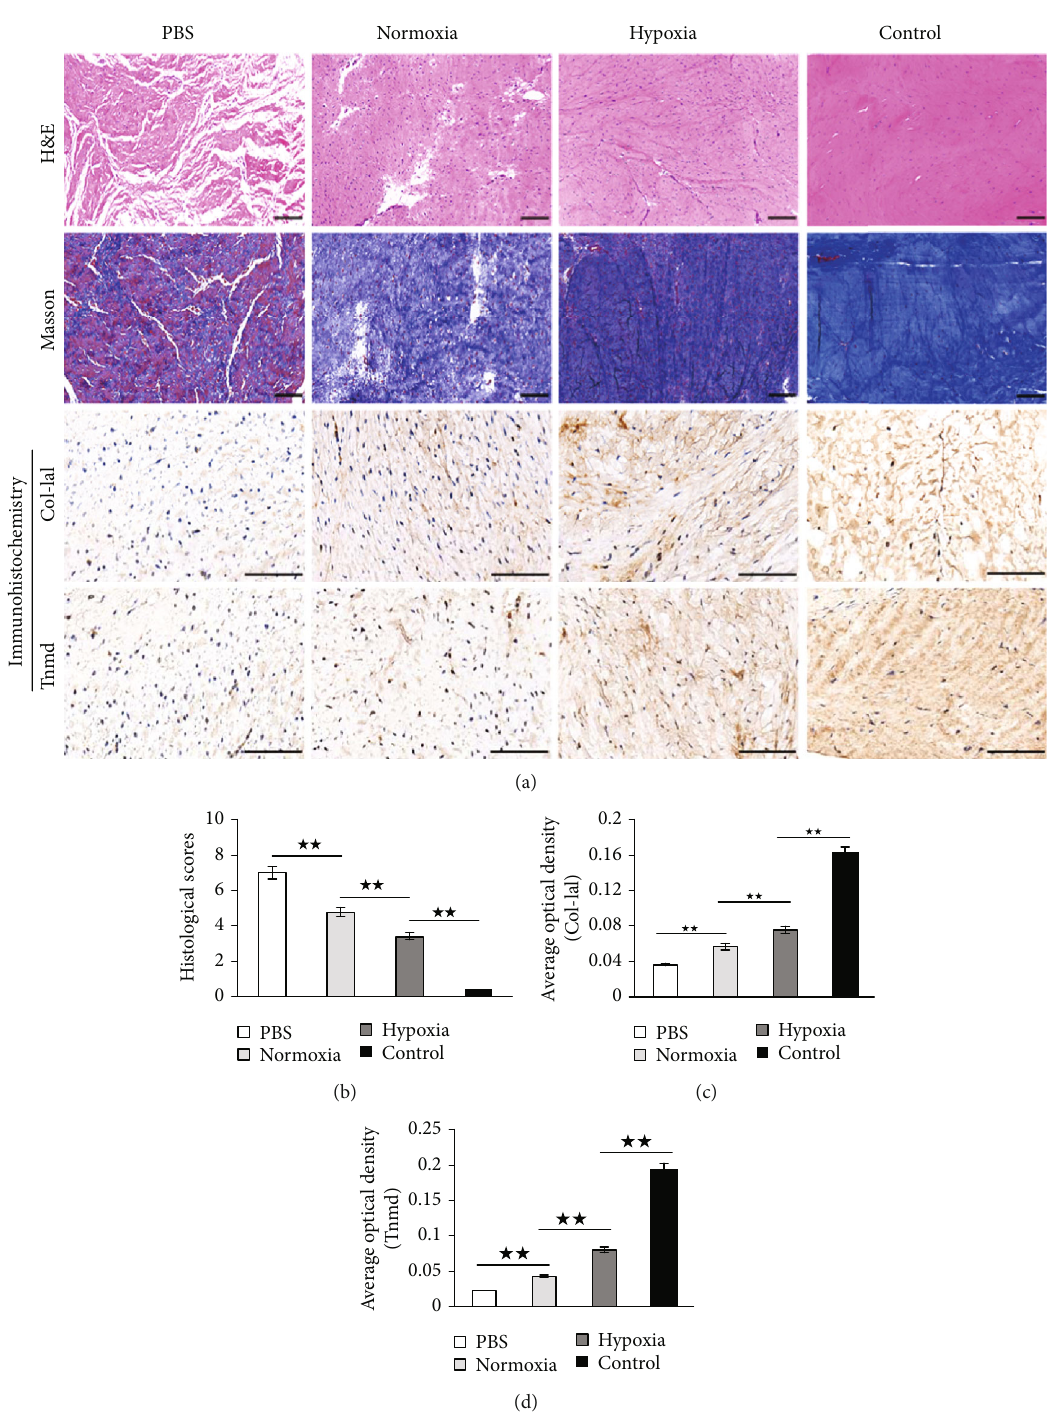
Figure 6: Histological analysis of specimen at 4 weeks after surgery. (a) Hematoxylin and eosin (H&E) staining, Masson ’ s trichrome staining, and immunohistochemical staining for Col-1a1 and Tnmd in the PBS group, the normoxia group, the hypoxia group, and the control (normal) group. (b) Quanti fi cation of histological properties after H&E staining in the PBS group, the normoxia group, the hypoxia group, and the control (normal) group. (c, d) Quanti fi cation of Col-1a1 (c) and Tnmd (d) after immunohistochemical staining in the PBS group, the normoxia group, the hypoxia group, and the control (normal) group. H&E and Masson ’ s trichrome staining: scalebar = 200 μ m; magni fi cation: × 200. Immunohistochemical staining: scale bar = 200 μ m; magni fi cation: × 400. Data were shown as mean ± SD . ★★ p < 0 : 01